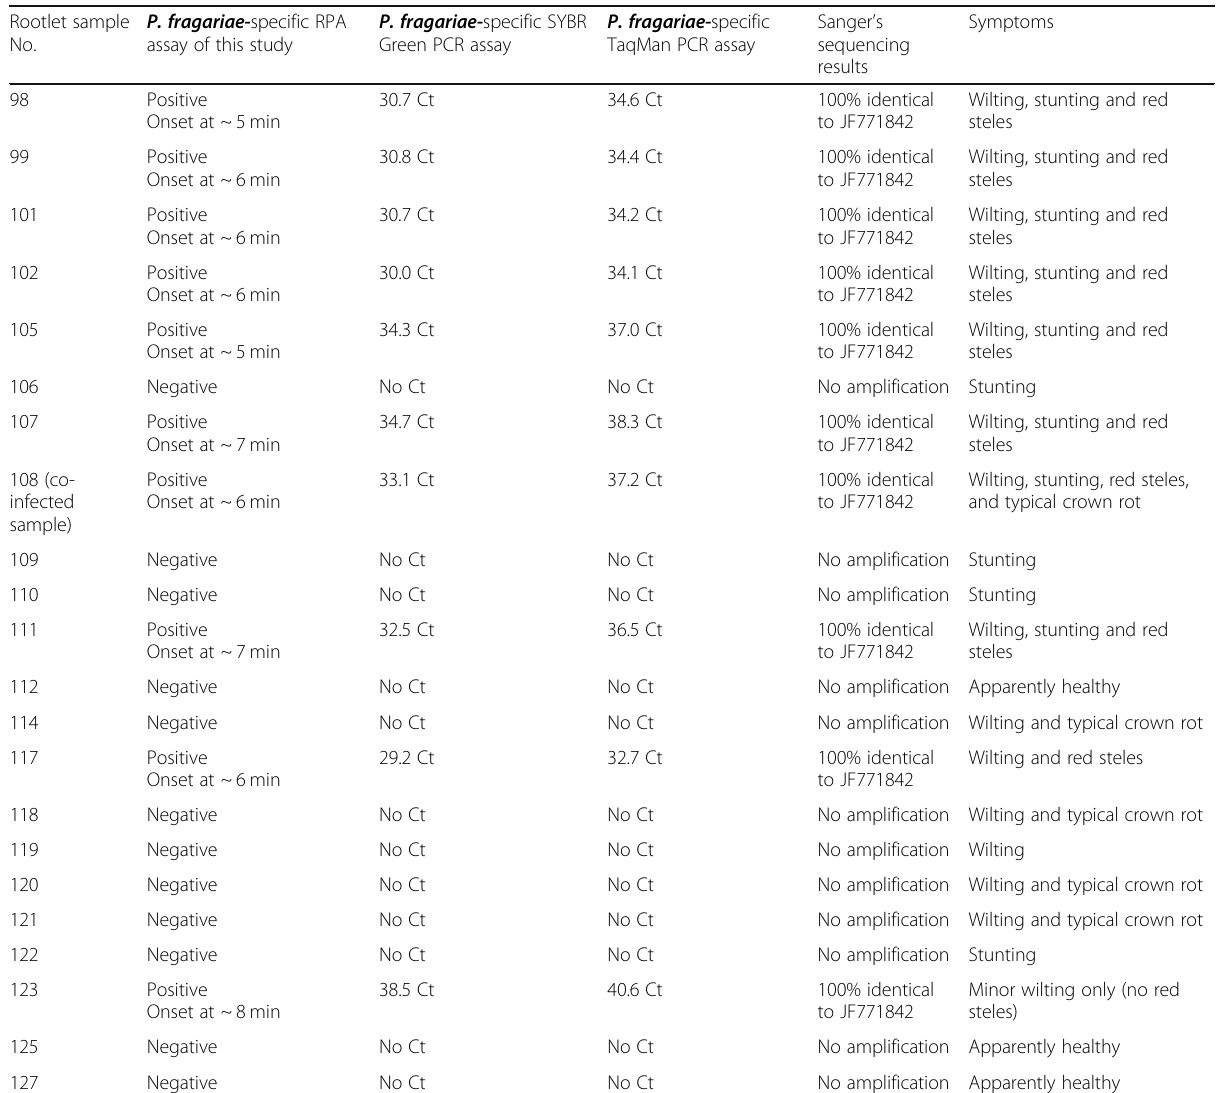
Table 3 Field validation results Rootlet sample No.